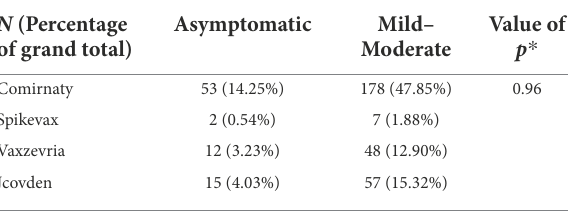
TABLE 5 Contingency table of vaccine type vs.